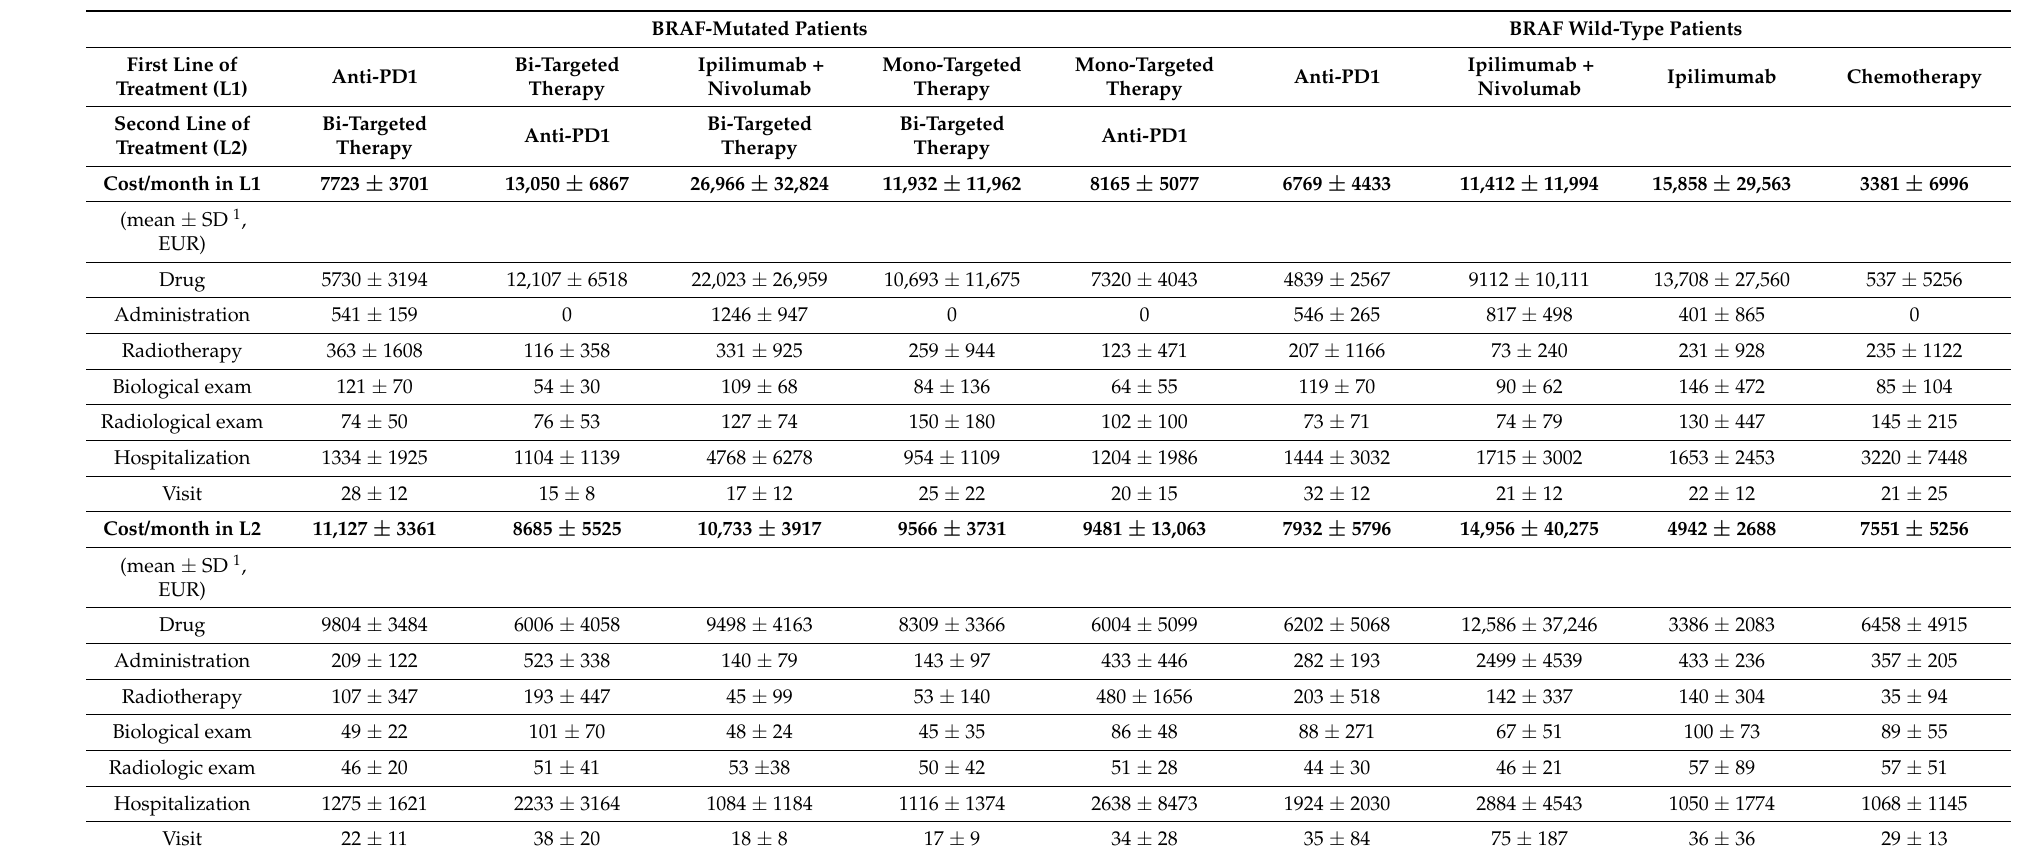
Table 2. Monthly cost of management per patient and utility scores observed from the MelBase cohort, in the BRAF-m and BRAF-wt